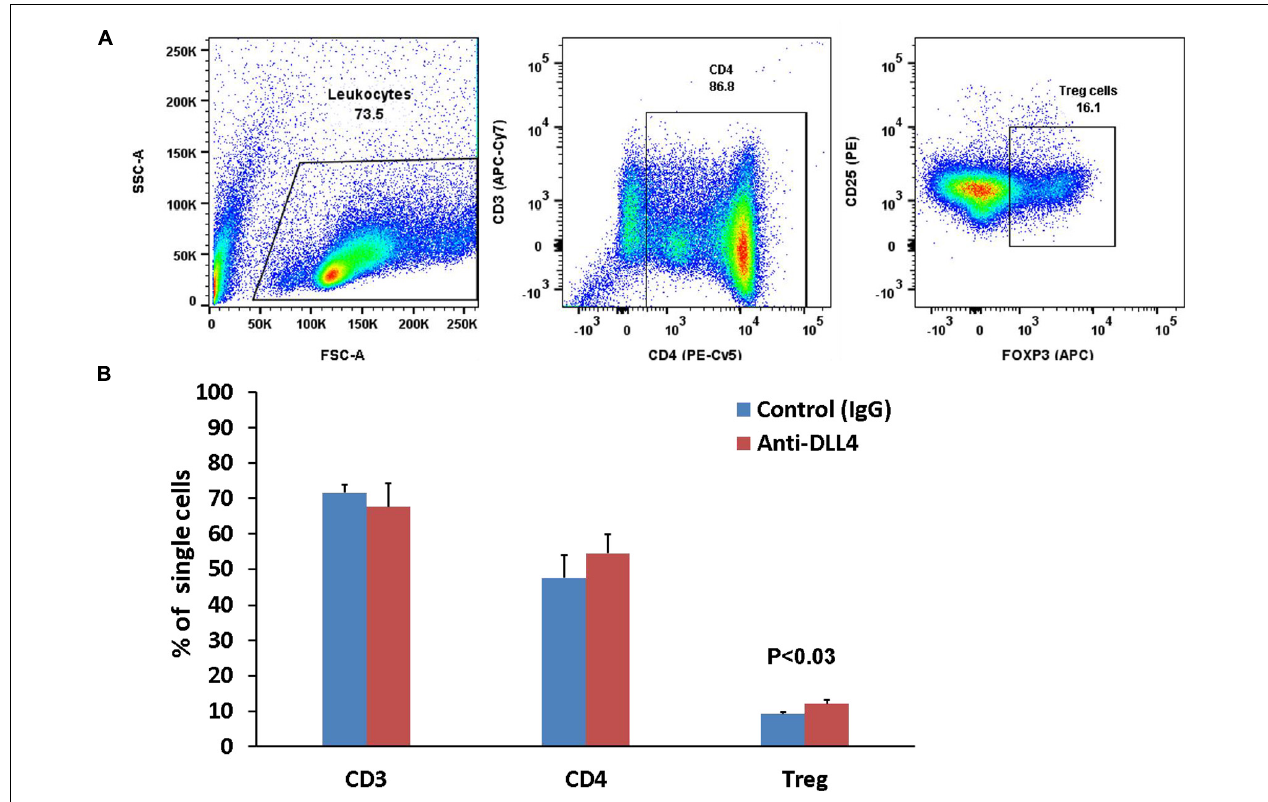
FIGURE 3 | Anti-DLL4 significantly enriches the thymic Treg population. Representative flow-cytometry (dot plots) of thymus (A) of mice single cell suspensions were stained with fluorochrome-conjugated antibodies. Total leucocytes were gated from single cells and subsequently gated for CD3, CD4 and Treg cells ( n = 4 per group). Data shown in histograms for CD3, CD4 and Treg cells were seen in anti-DLL4 and control IgG treated mice (B) . Most remarkably, significant Treg enrichment was observed in anti-DLL4 treated